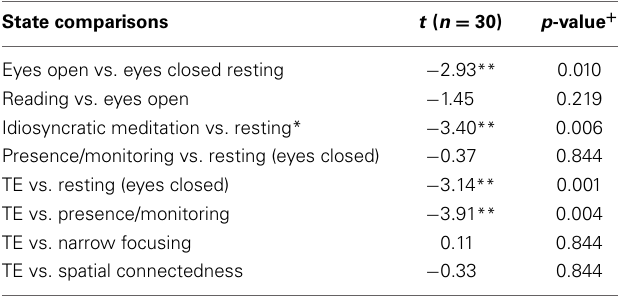
Table 1 | State comparisons on the level of the global field power have been